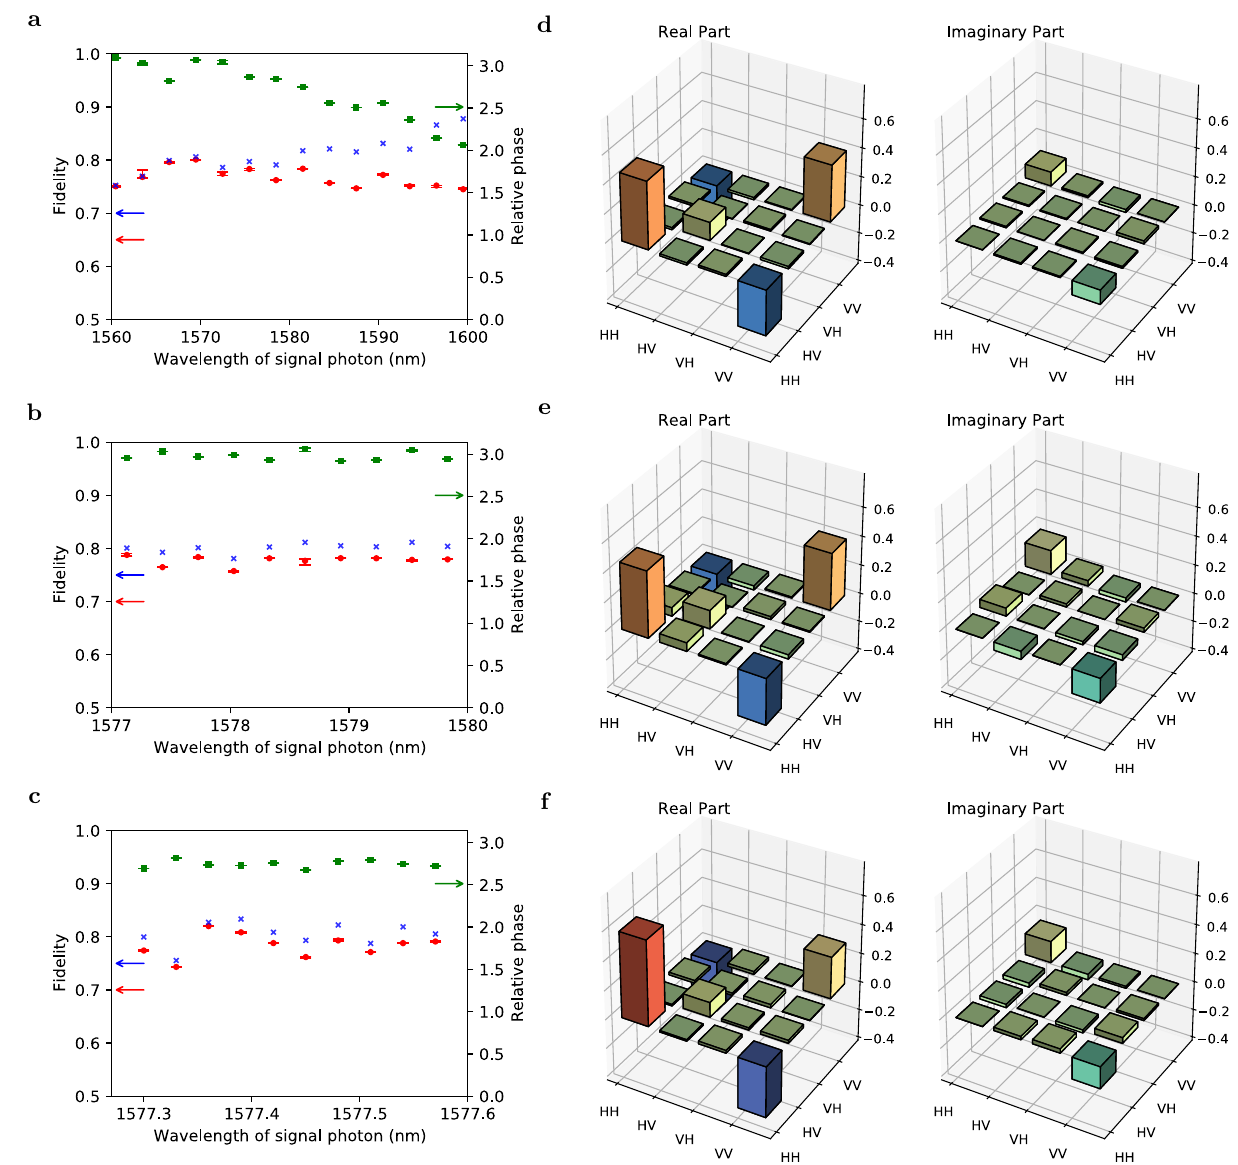
Figure 5. Fidelities and reconstructed density matrices of polarization entangled states. We performed a set of polarization measurements with various central wavelengths and bandwidths of BPFs. The data recording time at each polarization setting is 200 s. ( a – c ) Red, green, and blue markers represent the fidelity of the quantum state, relative phases between the polarizations of HH and VV of the reconstructed states, and expected fidelity after removing contamination with undesired components, respectively (see Supplementary Information). The error bars represent standard deviations under the assumption of Poisson statistics for the photon counts. The frequency ranges are ( a ) [1560.48 nm, 1599.48 nm] and [1522.43 nm, 1560.48 nm], ( b ) [1577.13 nm, 1579.83 nm] and [1541.60 nm, 1544.18 nm], and ( c ) [1577.30 nm, 1577.57 nm] and [1543.76 nm, 1544.01 nm] for bandwidths of 3.00 nm, 0.30 nm, and 0.03 nm, which correspond to 100, 10, and 1 frequency modes, ∼ respectively. Examples of the reconstructed density matrix are shown in ( d – f ) with spectral resolutions of 3.00 nm, 0.30 nm, and 0.03 nm, respectively. The combinations of the frequency modes are ( d ) 1578.48 nm and 1542.89 nm, ( e ) 1577.43 nm and 1543.89 nm, and ( f ) 1577.39 nm and 1543.93